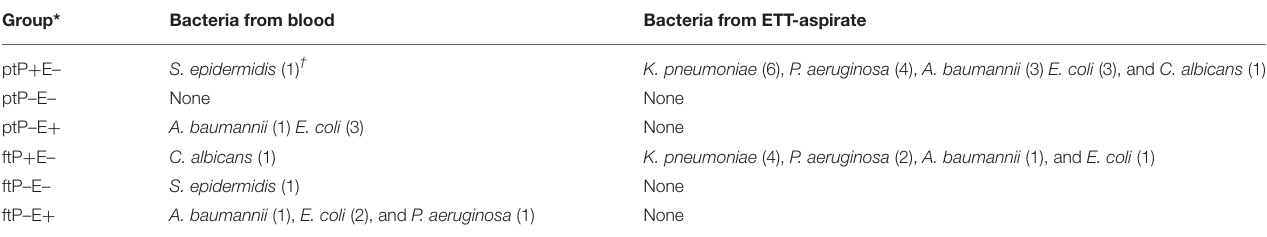
TABLE 1 | Bacterial culture results of serum and ETT-aspirate in each group. Group* Bacteria from blood Bacteria from ETT-aspirate